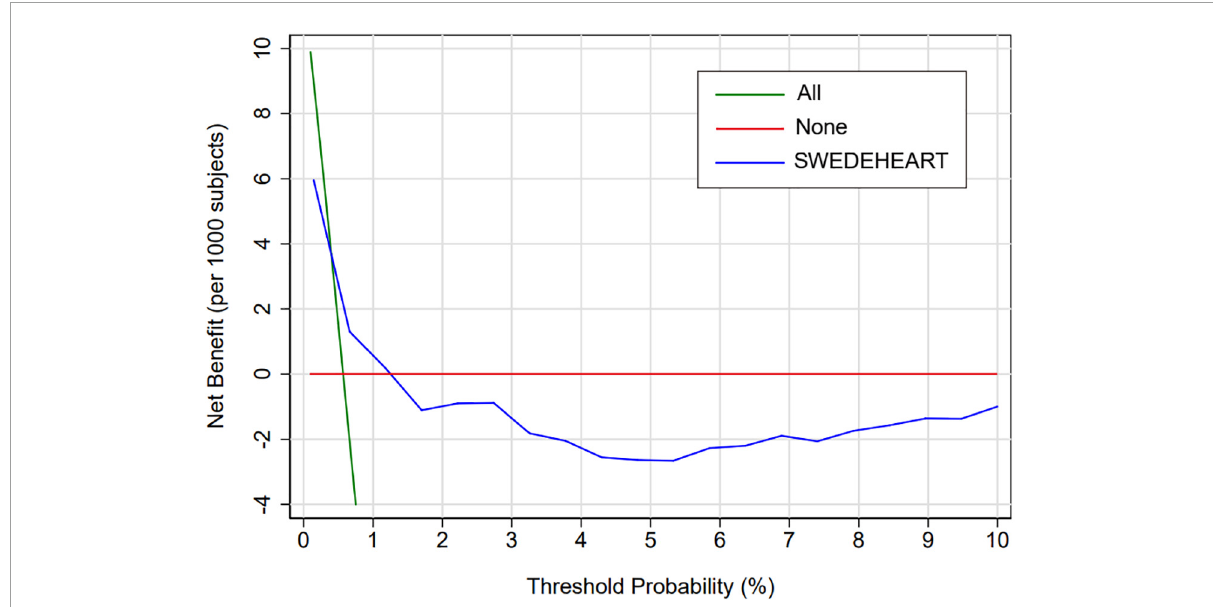
FIGURE3 Decision curve analysis of SS among the overall population. Decision curve analysis for SS. The y -axis measures the net benefit. The x -axis measures the threshold probability. The blue line represents SS. The green line represents the assumption that all patients have an absolute risk of bleeding. The red line represents the assumption that no patients have any risk of bleeding. The decision curve shows that, if the threshold probability of a patient ranges from 0.4 to 1.3%, the patient would benefit from using SS to predict the in-hospital major bleeding risk. SS, SWEDEHEART